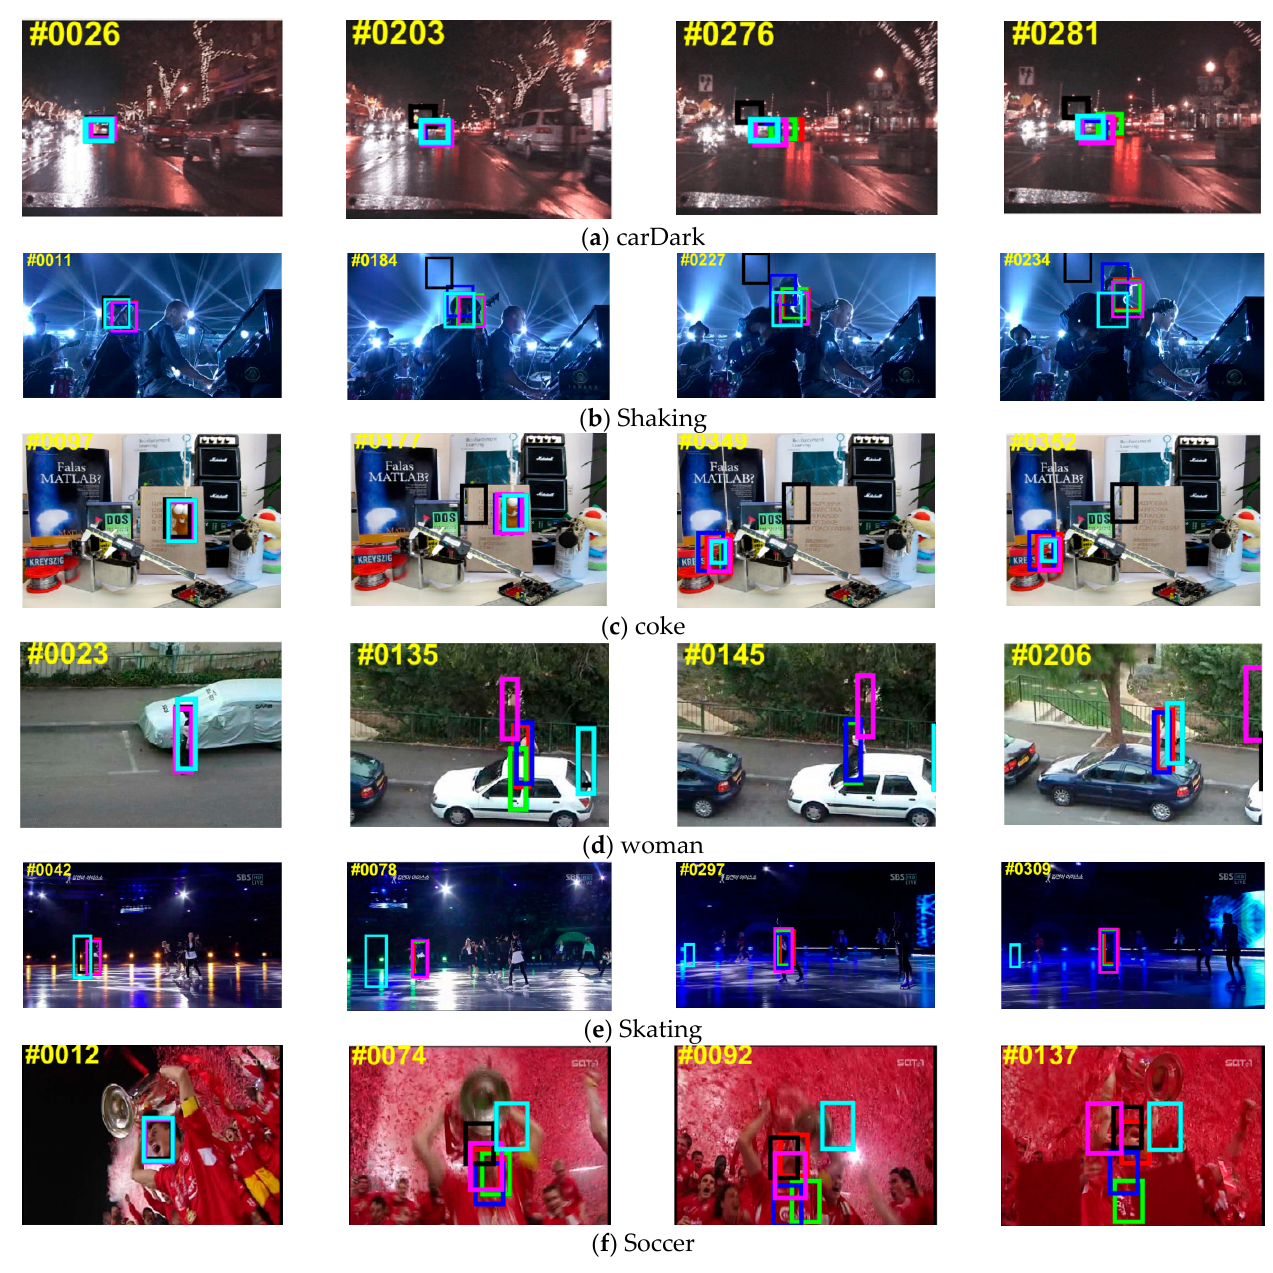
Figure 5. Partial video sequence tracking results. TLD.